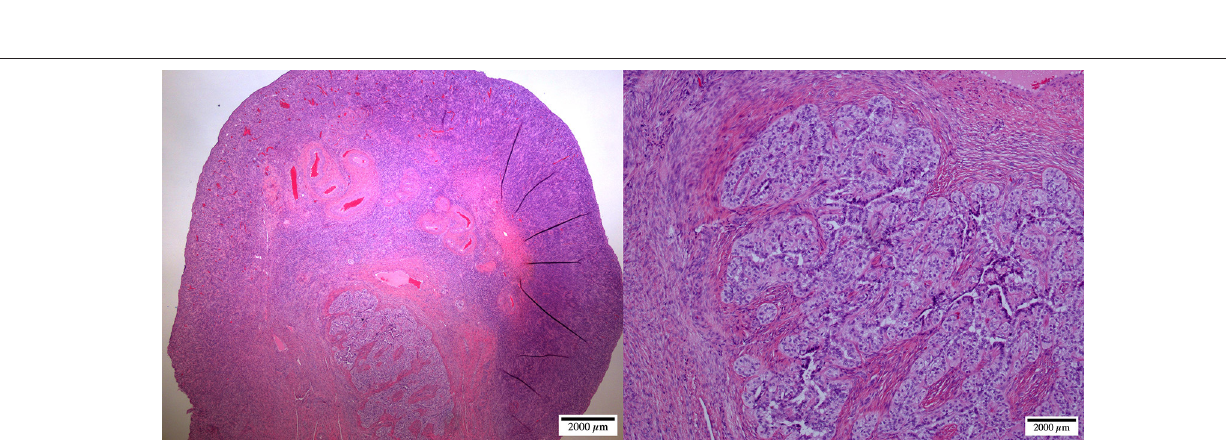
Frontiers in Veterinary Science |